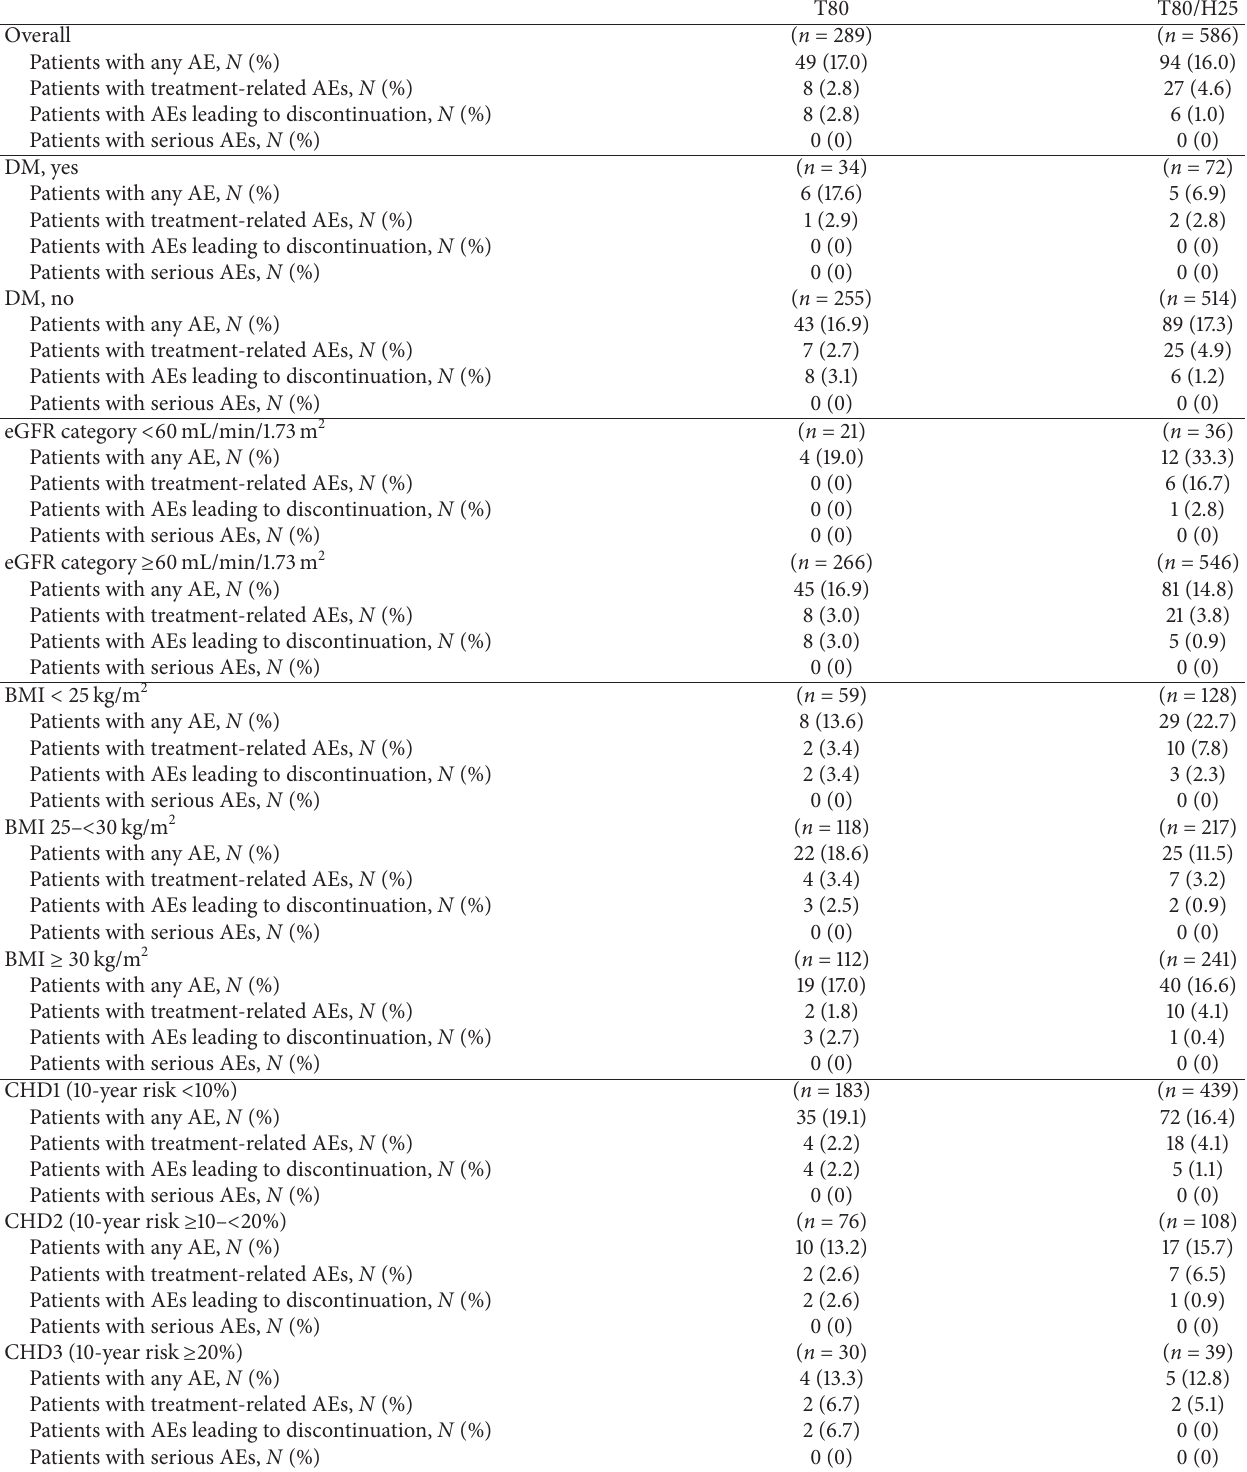
Table 4: Summary of AE frequencies in the different patient subpopulations, based on treated